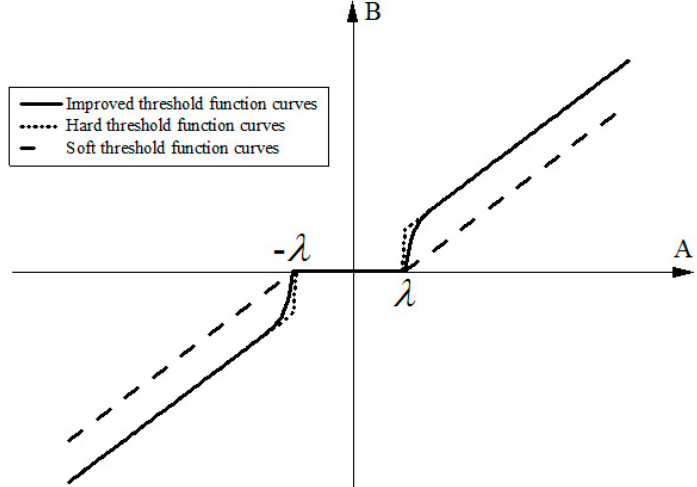
Figure 3. Three kinds of threshold function curve.